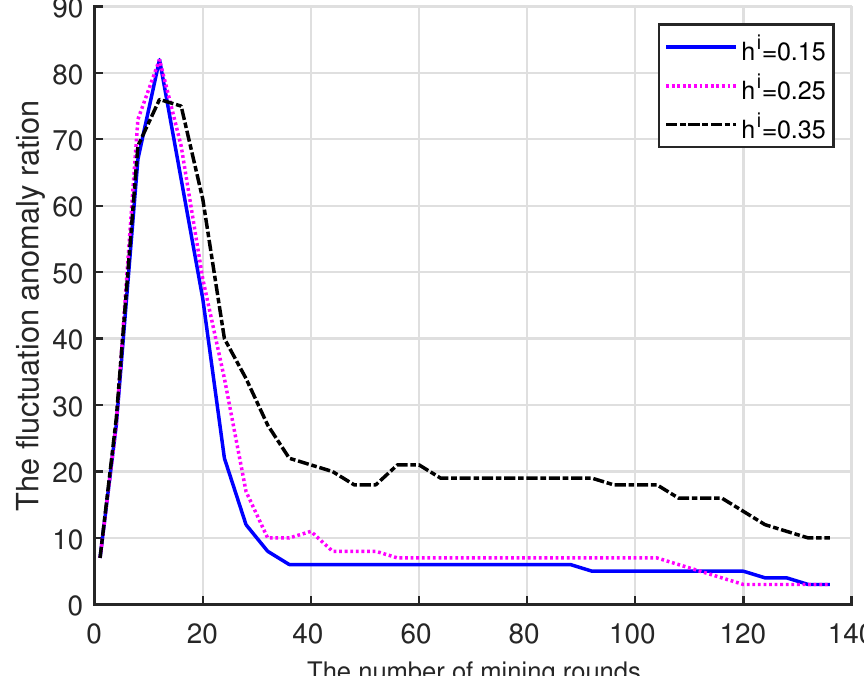
Figure 4. Mining rounds vs. Fluctuation.